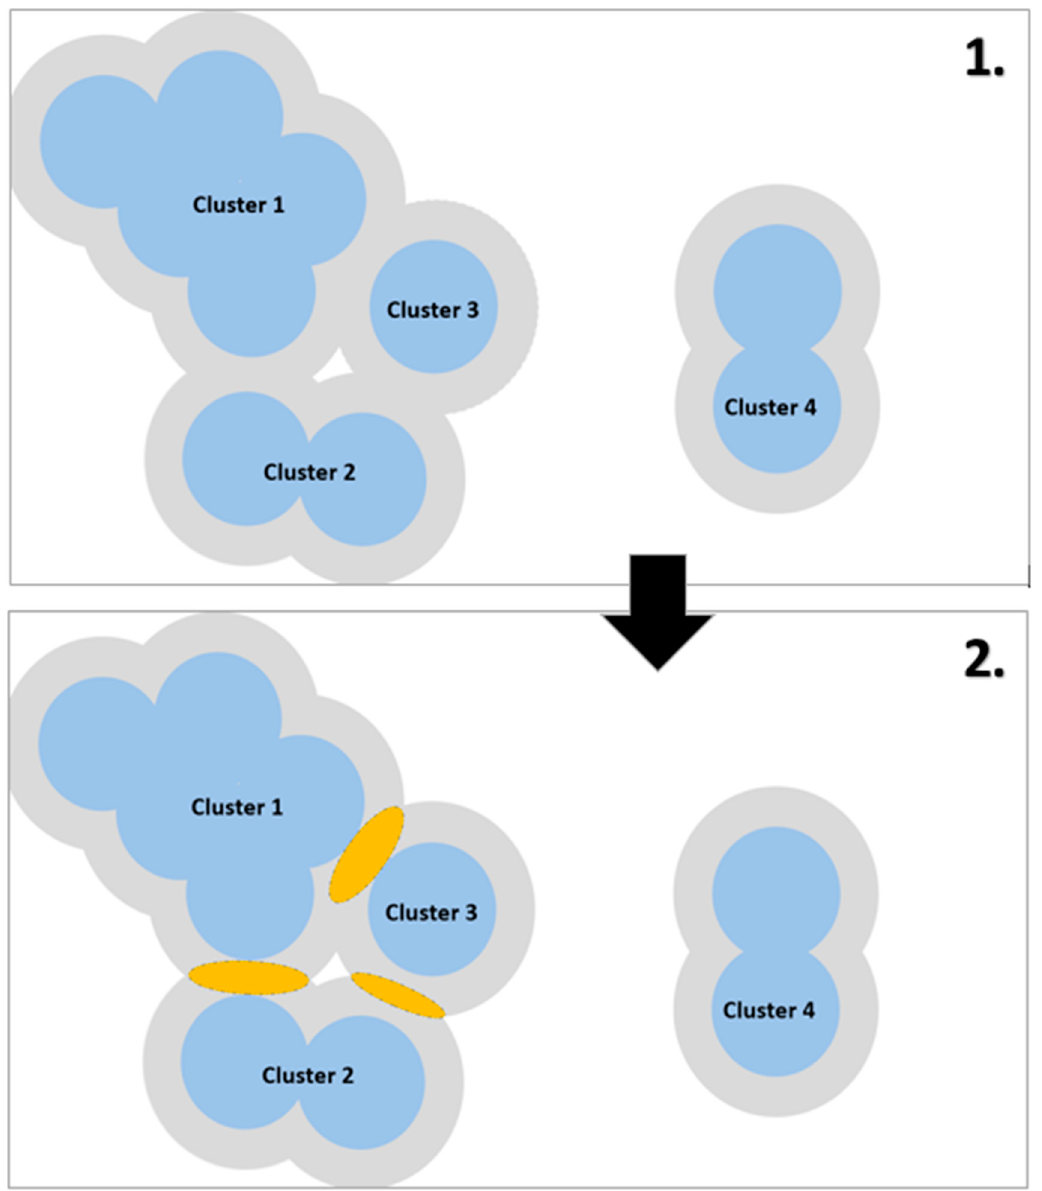
Figure 3. The method used to identify areas where artificial stepping stone biotopes could be created to improve functional connectivity for the studied species. Habitat clusters were assigned buffers corresponding to half of an indicator species’ movement range (grey) (1). In areas where buffers overlap (orange), the creation of artificial stepping stone biotopes would connect clusters and improve functional connectivity